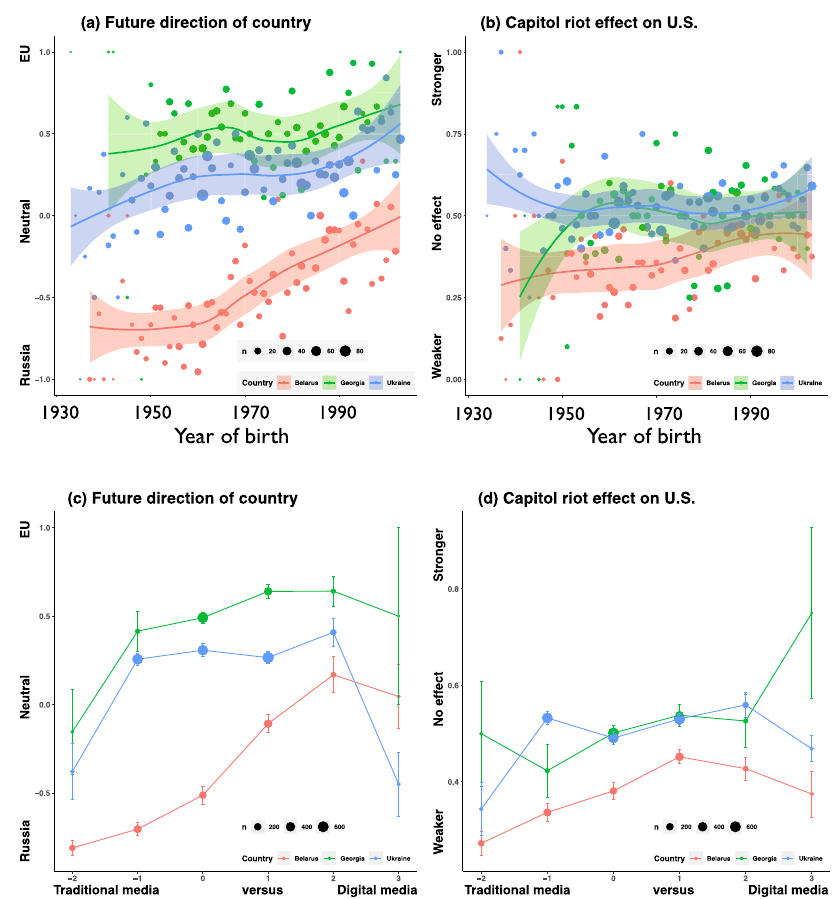
Fig. 1 Effects on opinions. Top row: The effect of respondent age on opinions about. a The future political alignment of the country towards Russia versus the E.U., and b U.S standing following the Capitol riot. Bottom Row: Effect of digital media source on those same opinions, in c and d , respectively. Symbol size represents how many responses, n , are averaged by that symbol.